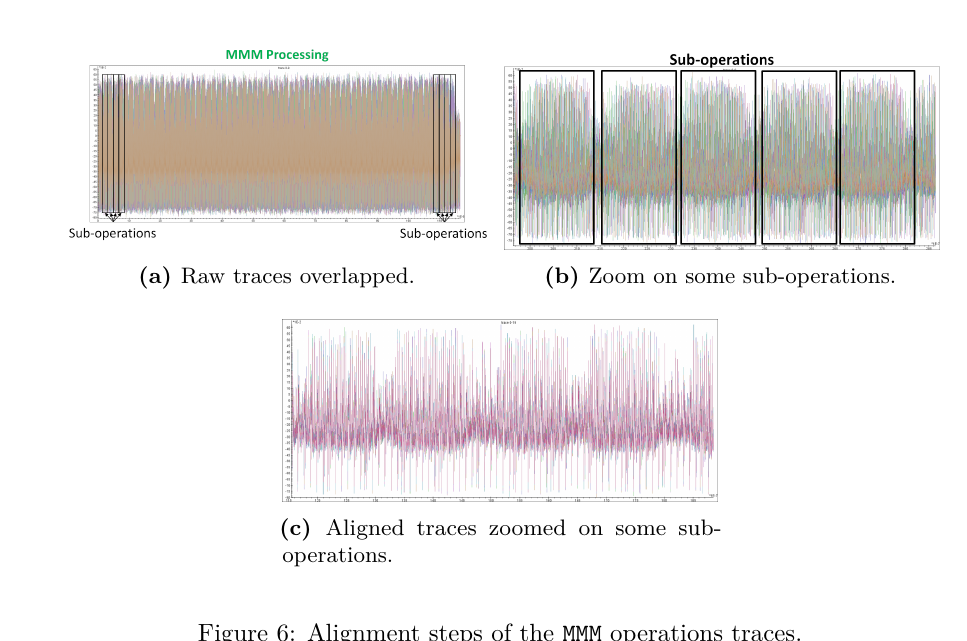
Figure 6: Alignment steps of the MMM operations traces.